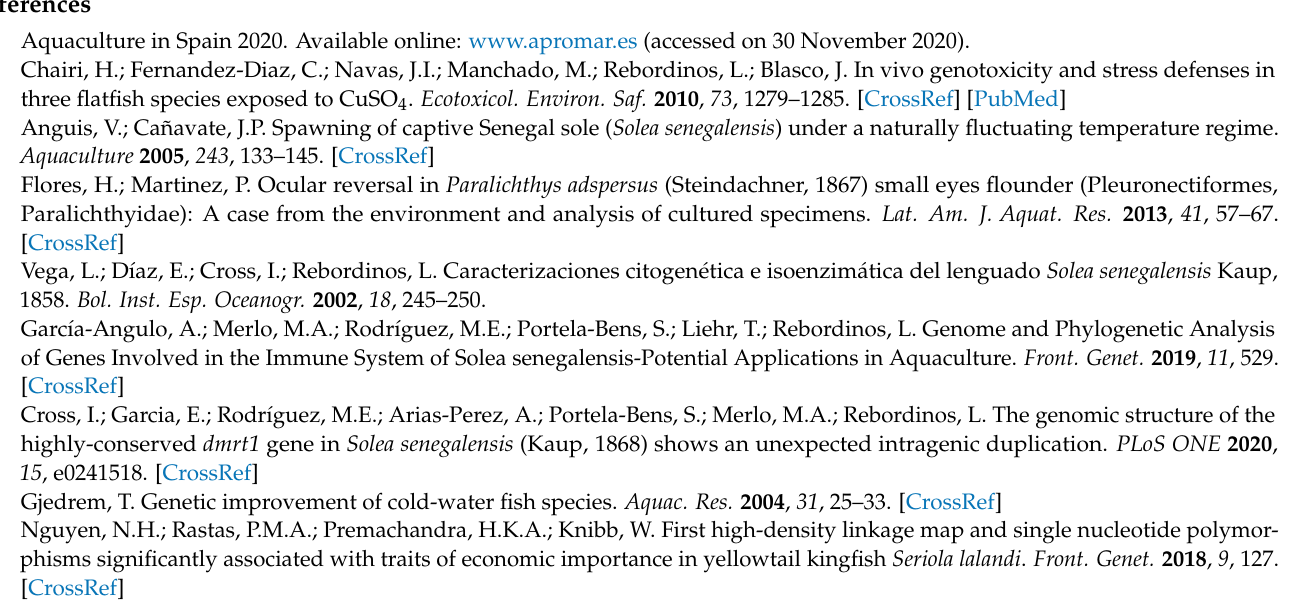
Table S2: Group of conserved linkages across the different species treated in the study and the GO link of each